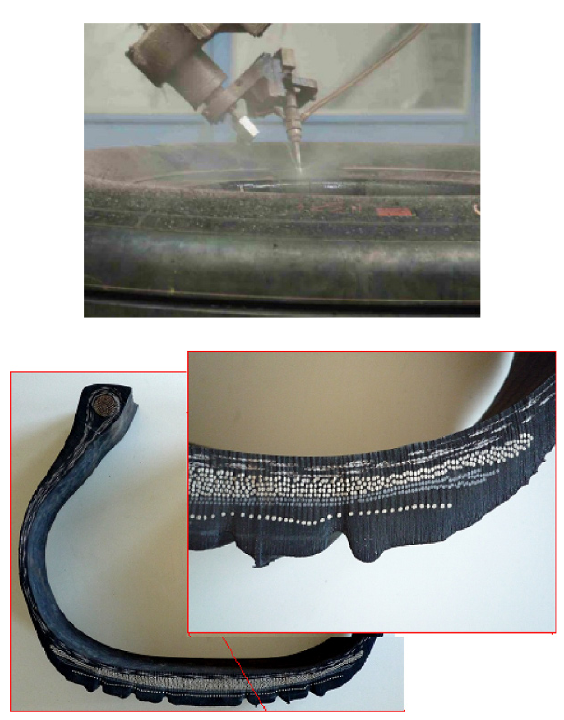
Figure 6. Water jet cutting and layout of the composite structure.